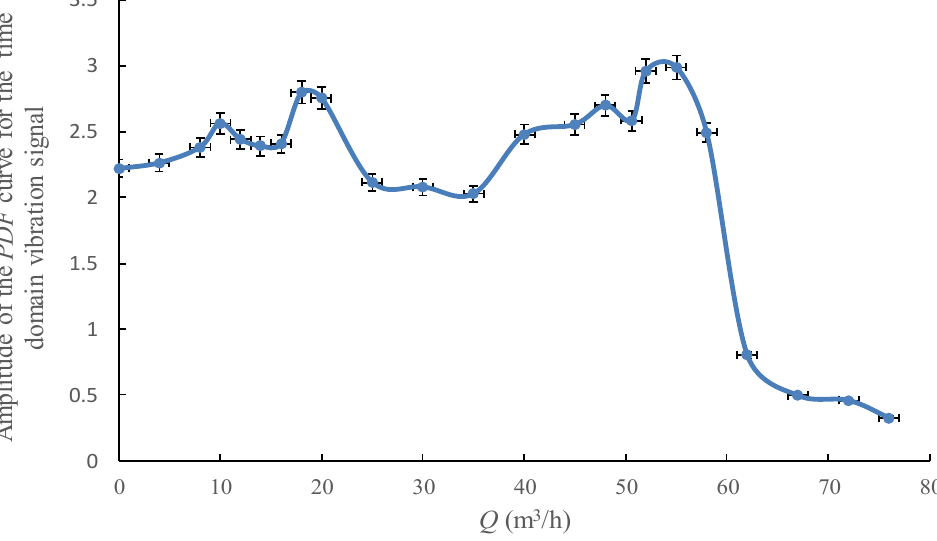
Figure 14. Amplitude of the probability density function ( PDF) curve for the time domain vibration signal under different flowrates.